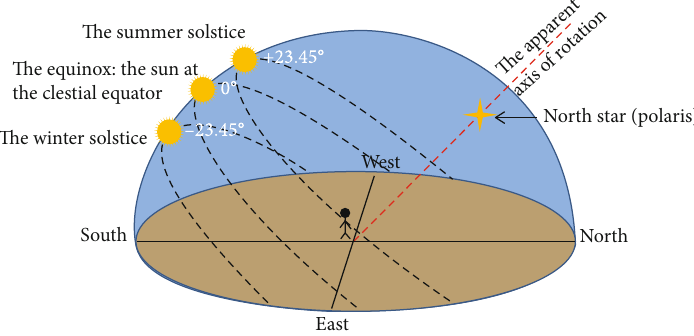
Figure 11: The angle of solar declination.